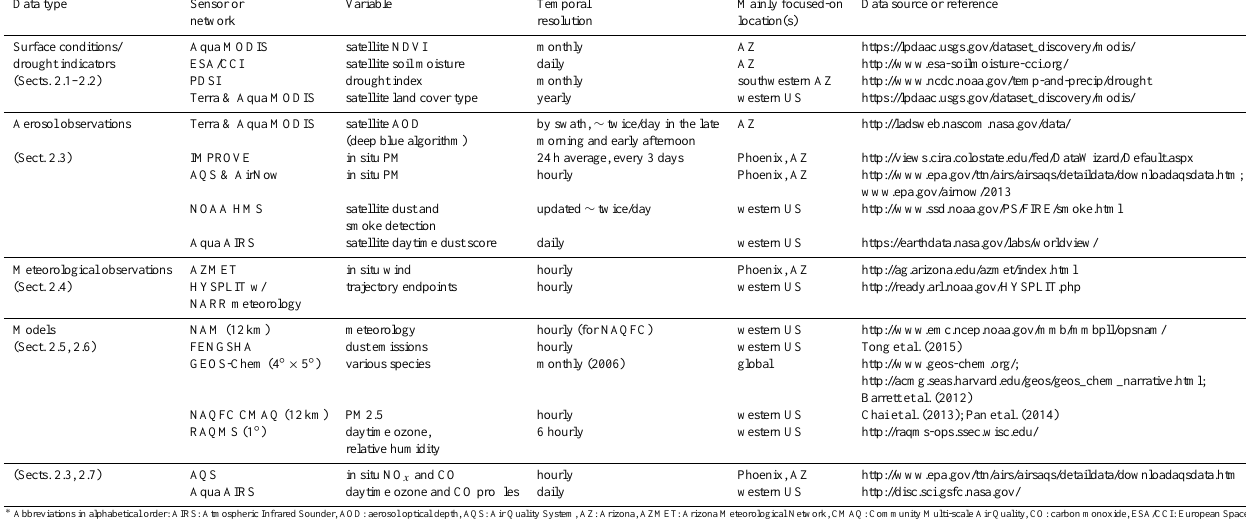
Table 1. Data used in this study ∗ .